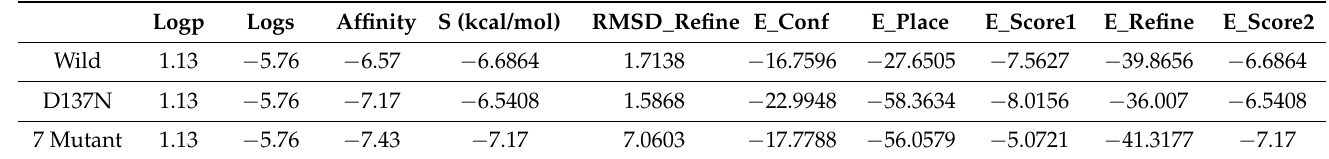
Table 3. The molecular docking of N -succinyl- L -alanyl- L -alanyl- L -prolyl- L phenylalanine 4 ni- troanilide S-9205 against